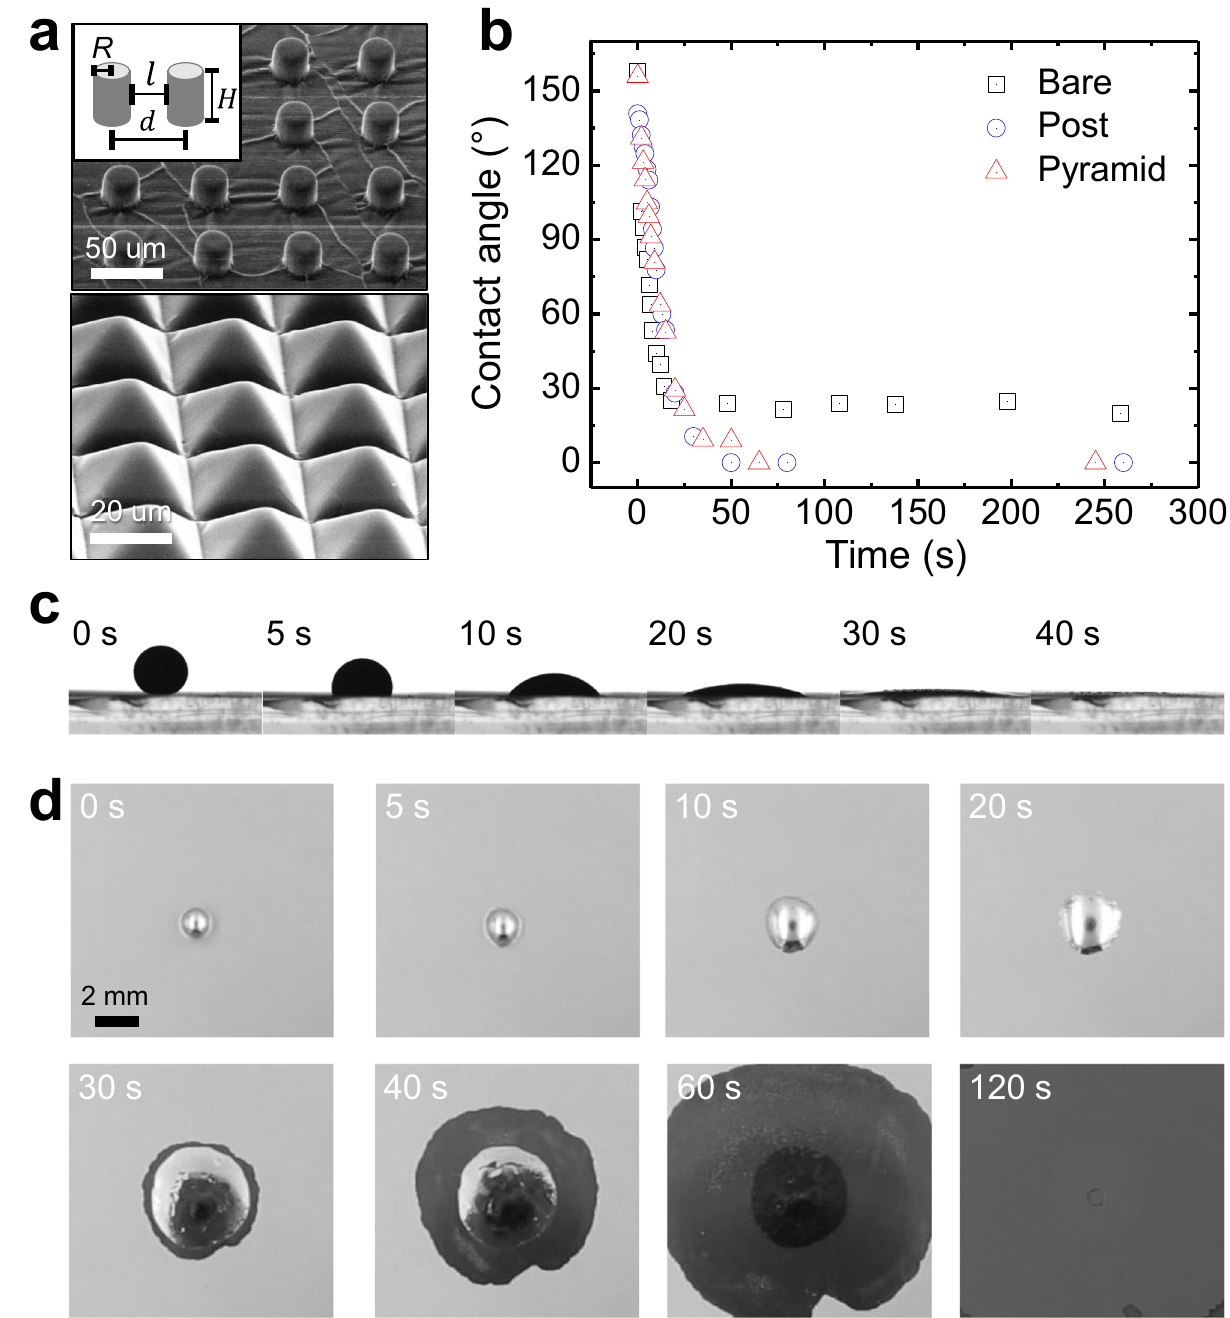
Fig. 1 | Imbibition-induced wetting phenomena of EGaIn on a metal-deposited surface with microstructures in the presence ofHCl vapor. a Scanning electron microscope (SEM) images of posts ( D (diameter)= l (spacing)=25 μ m, d (distance between posts)=50 μ m, H (height)=25 μ m) and pyramids (width=25 μ m, height=18 μ m)-shaped microstructures on Cu/PDMS substrates. b